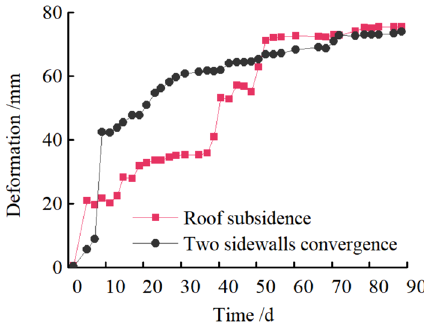
Figure 32. Deformation of Roadway.